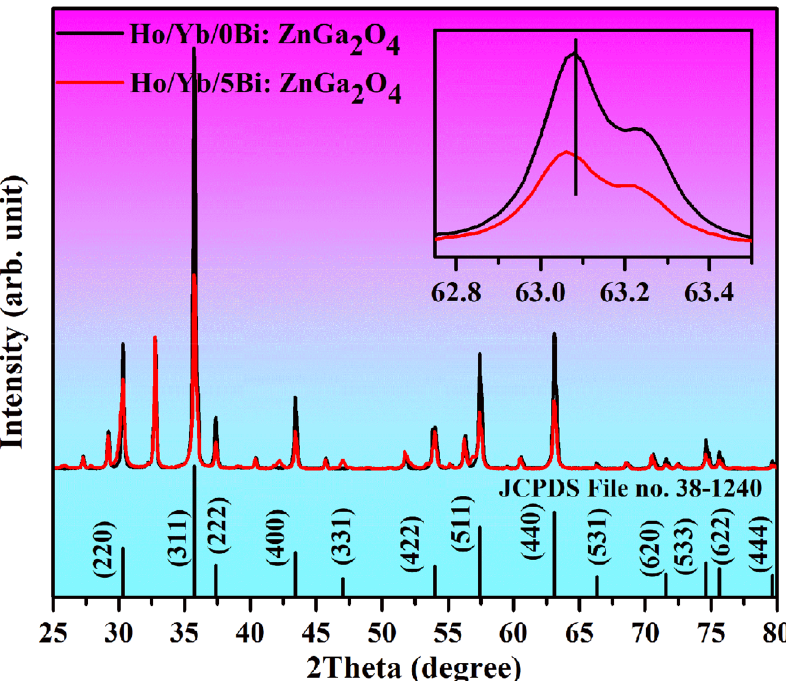
Figure 1. The XRD patterns of the Ho 3+ /Yb 3+ co-doped ZnGa 2 O 4 phosphor materials with and without the Bi 3+ ion and the inset of Fig. 1 shows a variation of FWHM and a shift in XRD peak for 63.06°